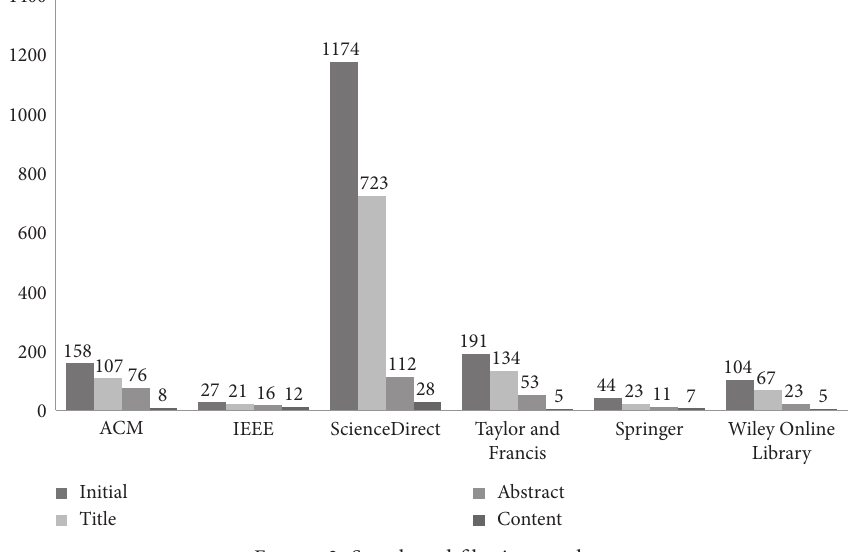
Figure 3: Search and filtering results.